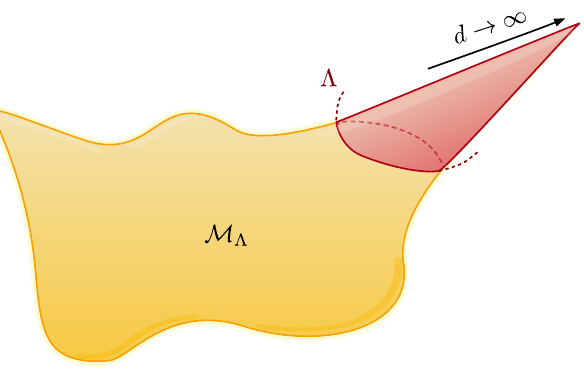
Figure 7 . The moduli space M Λ accessible within an EFT characterised by a cutoff Λ